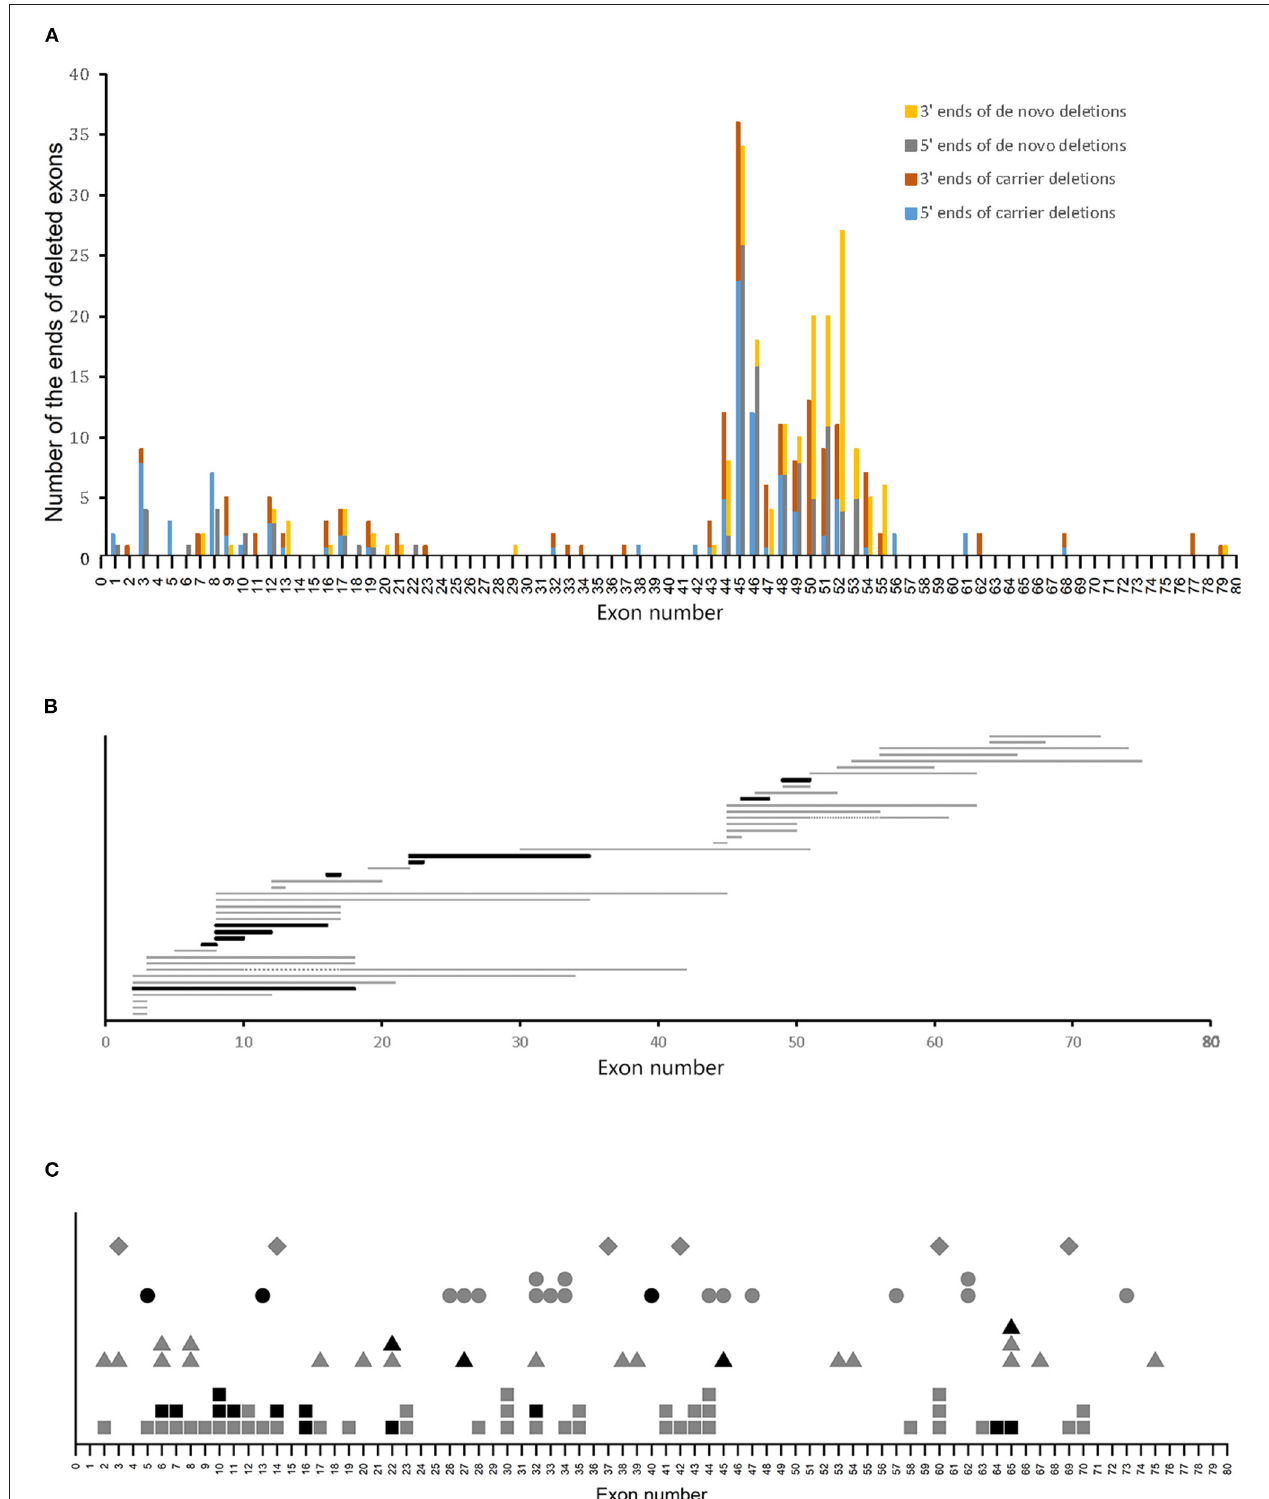
FIGURE 2 | Variant sites in patients with DMD. (A) Distribution of ends of deletions in patients with DMD. (B) Distribution of duplications in patients with BMD. Horizontal bars represent the duplicated regions. Gray and black bars represent carrier and de novo variants, respectively. Two patients with carrier duplications had two duplicated regions each, and the two duplicated regions were connected with gray dotted lines. (C) Distribution of small mutations. Gray and black symbols represent carrier and de novo variants, respectively. Squares, triangles, circles, and rhombus represent non-sense mutations, splice site mutations, small deletions/insertions, and missense mutations,